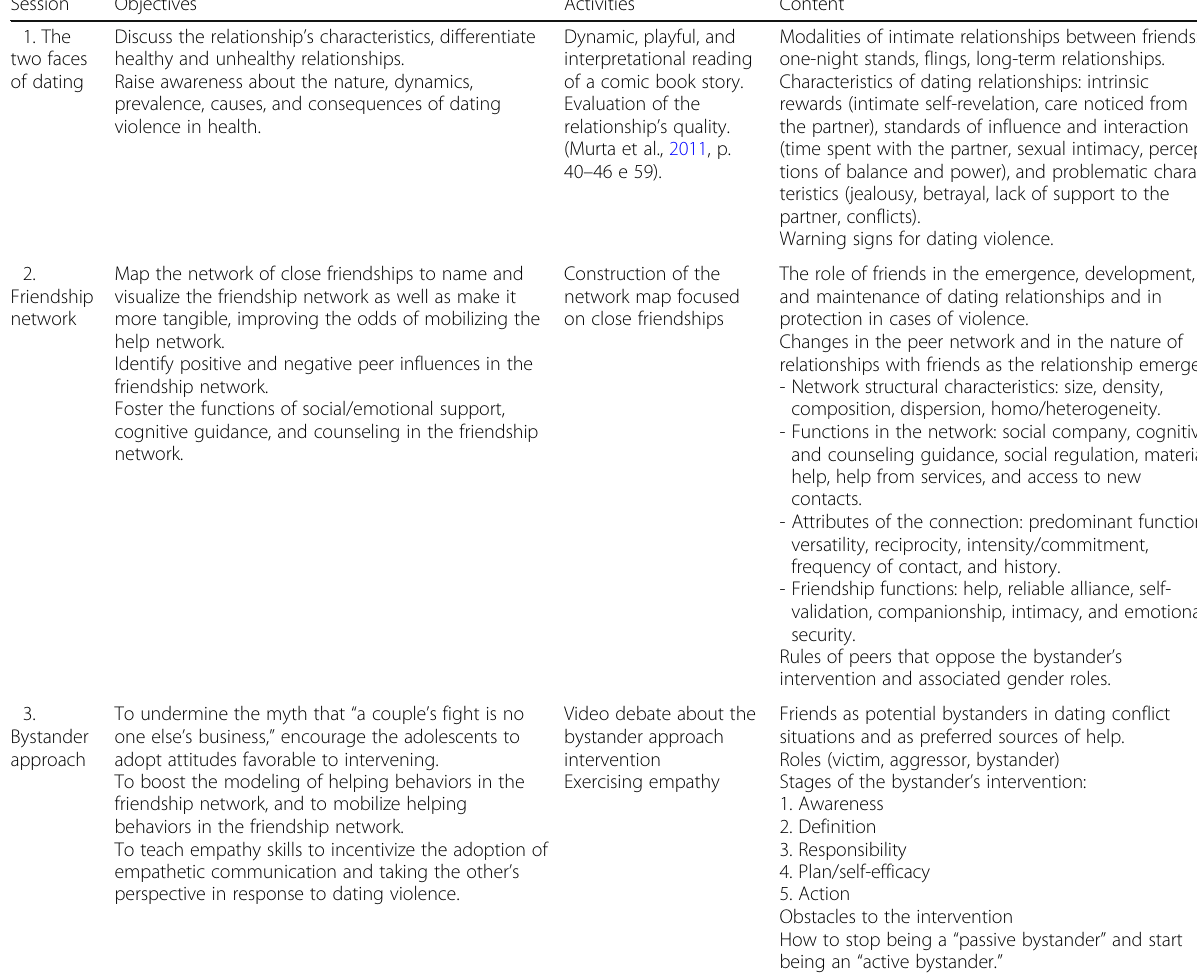
Table 1 General overview of the intervention Session